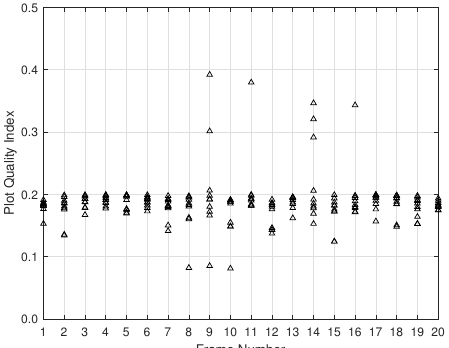
Figure 11. The plot quality indexes of the selected false plots.